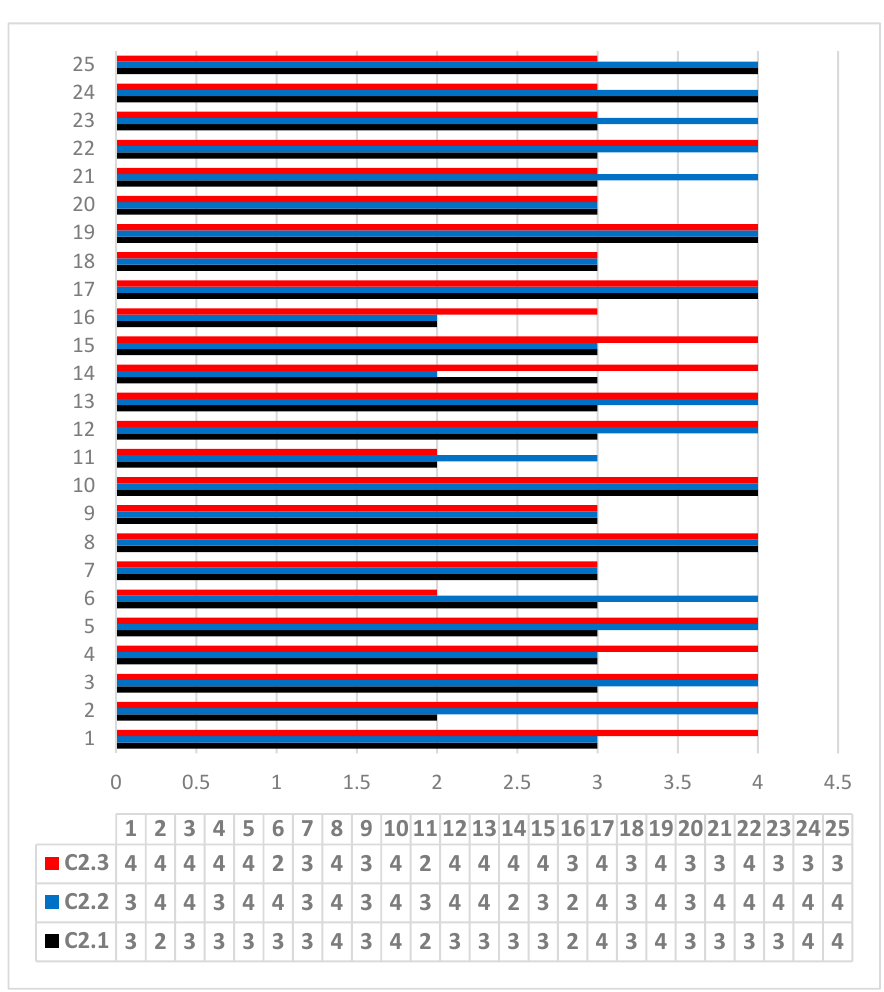
Figure 4. Experts’ opinion concerning the importance of the water services indicators: C2.1 water coverage (WC), C2.2 water losses (WL), C2.3 continuity of water supply